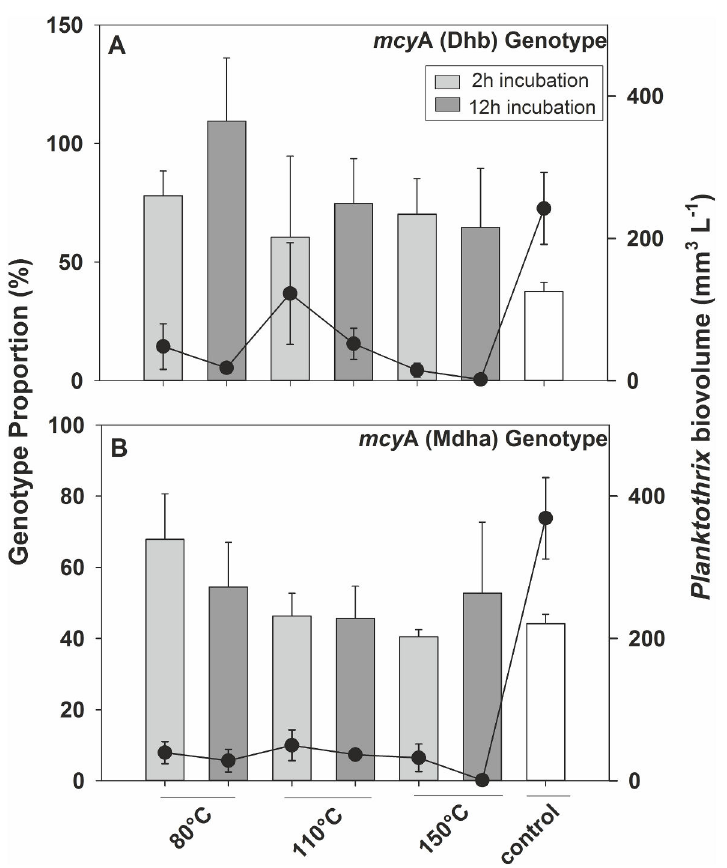
Figure 1. Average ± SE mcy A genotype biovolume (black line) and proportion (bars) estimated by means of qPCR from Planktothrix cell material preserved at different desiccation temperatures during 2 h (light grey bars) and 12 h (dark grey bars) of incubation. (A) Dhb genotype; (B) Mdha genotype. doi: